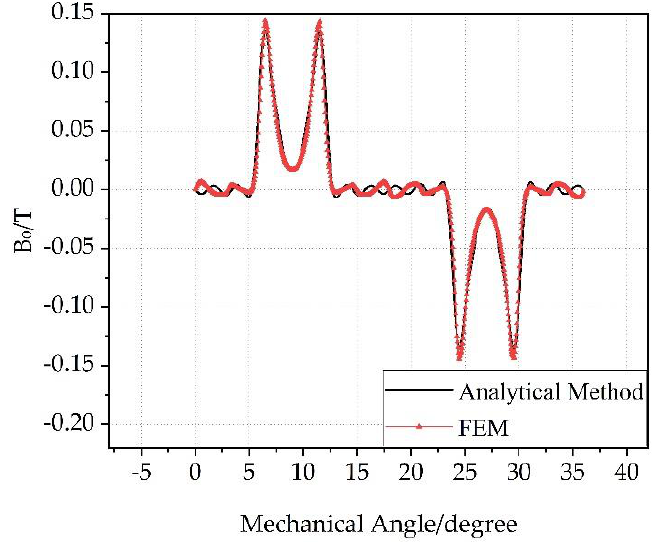
Figure 9. Comparison of the tangential component of magnetic field.